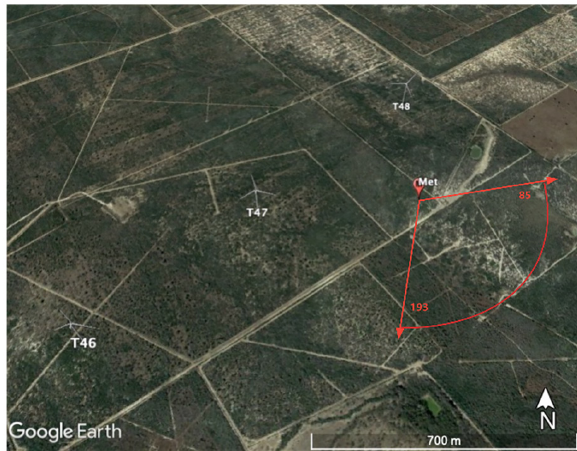
Figure 8. Effective measurement sector of the met mast.